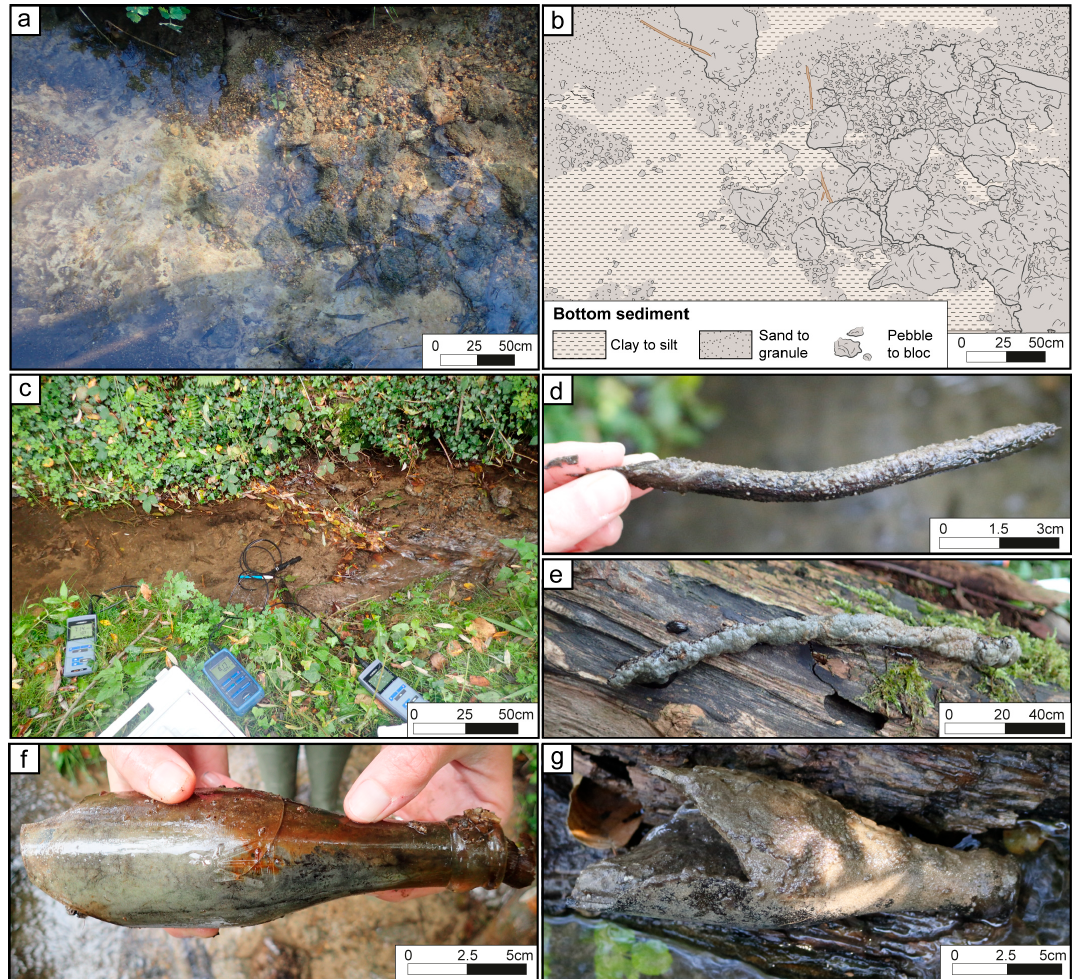
Figure 10. Main characteristics of Zone 3 from the footbridge to the point of confluence with the river (see Figure 2 for exact location). ( a ) View and ( b ) drawing of the bottom sediment mainly composed of coarse (pebble to block) material encrusted by tufa microbialites; ( c ) single channel (20 cm-deep) with high-velocity current and small topographic break; ( d ) fragment of wood encrusted by a mm-thick tufa microbialite; ( e ) fragments of iron encrusted by tufa microbialite; ( f ) shard of glass (broken bottle) without tufa microbialite during the first field campaign (October 2016); ( g ) tufa microbialites developed on the same glass shard (October 2018).